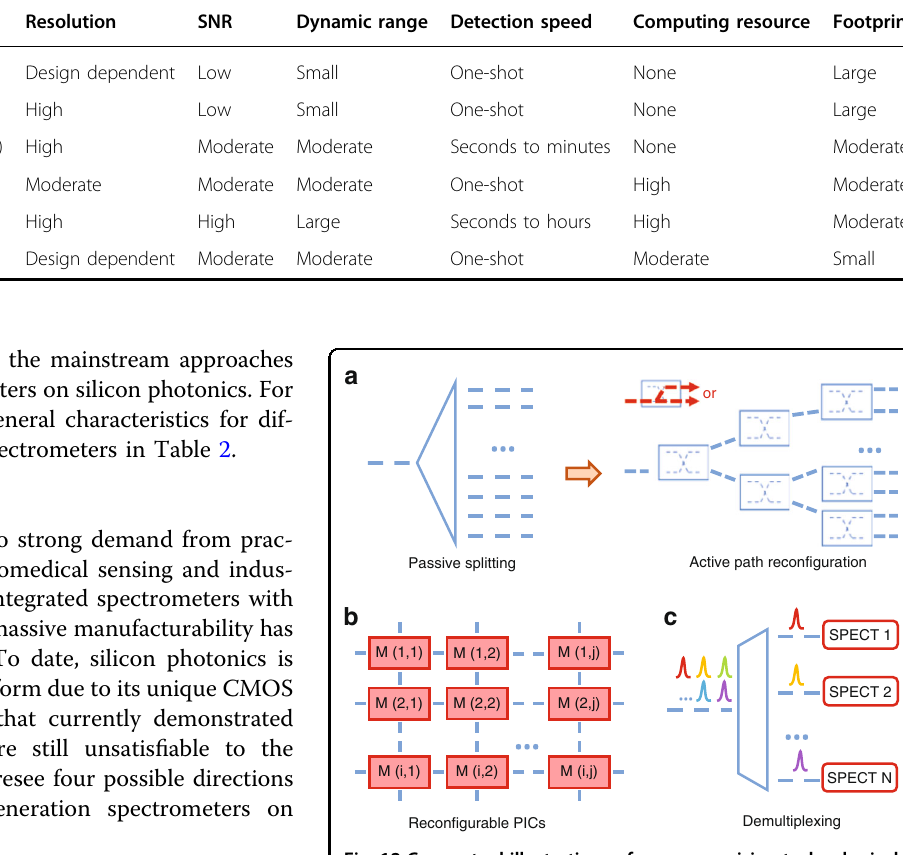
Fig. 12 Conceptual illustrations of some promising technological paths toward the next-generation integrated spectrometers. a Computational spectrometers based on active path recon fi